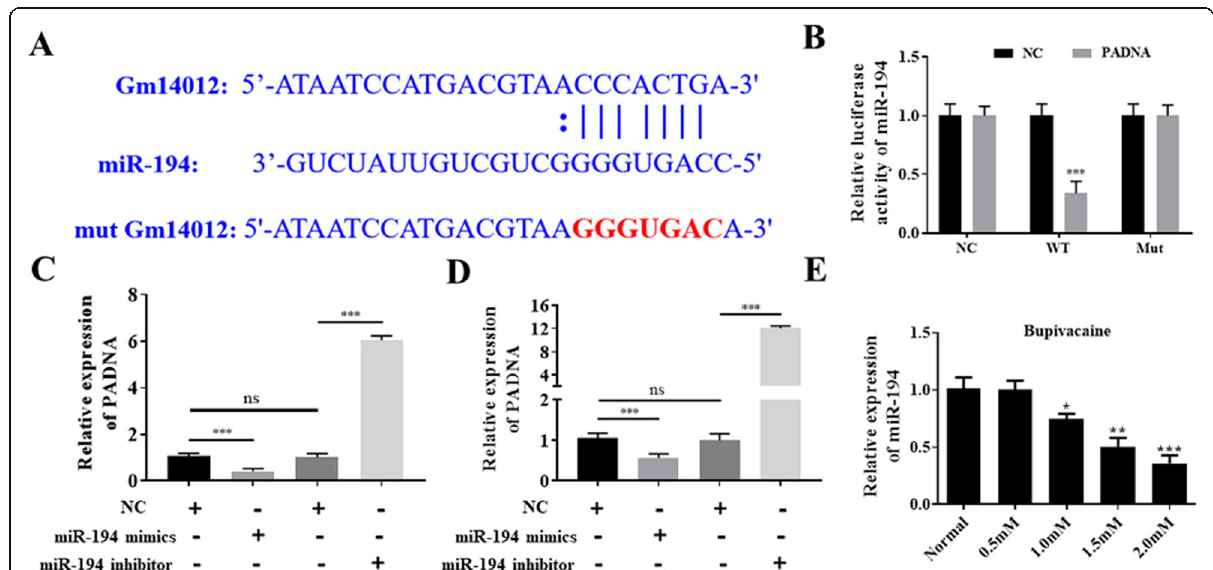
Fig. 3 miR-194 is the direct target of lincRNA PADNA. a The predicted binding sequence of lincRNA PADNA and miR-194. b The relative luciferase activity was significantly reduced in DRG neurons co-transfected with wt-lincRNA PADNA vector and miR-194 mimics than in DRG neurons co-transfected with mut-lincRNA PADNA vector or empty vector or mimic NC. c Overexpression of miR-194 distinctly reduced the expression of lincRNA PADNA in DRG neurons. d Overexpression of miR-194 distinctly reduced the expression of lincRNA PADNA in HEK293 cells. e The relative expression of miR-194 was manifestly reduced with the increase of concentration of bupivacaine. Data are Mean ± SD with n = 3 independent biological cultures. * p < 0.05 and ** p <